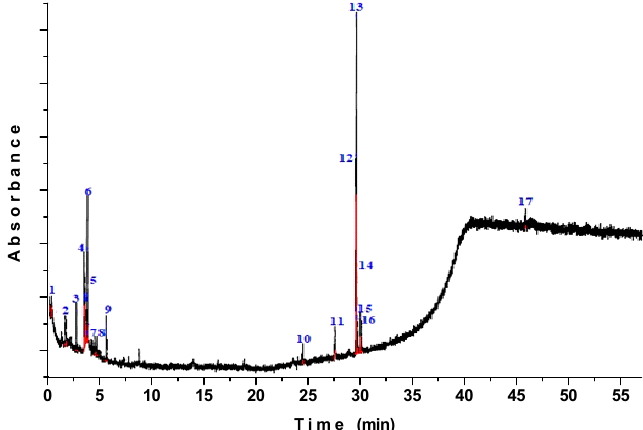
Figure 2. GC–MS chromatograms of sacha inchi oil after the simulated gastrointestinal digestion.